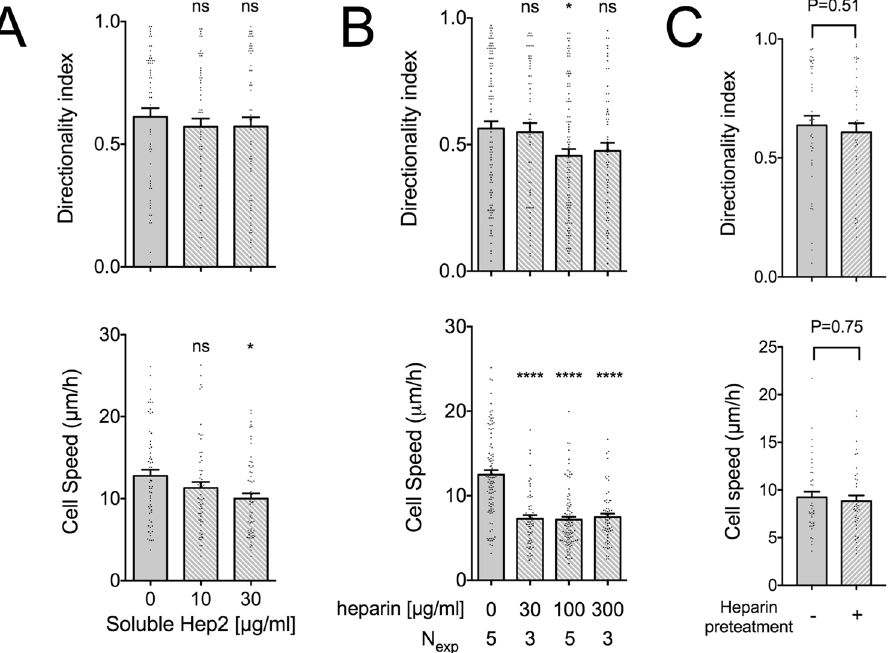
Figure 4. Soluble heparin reduces fibroblast speed on FN but has only a mild effect on directional persistence. ( A ) REF speed on FN-coated substrates (10 μ g/ml) slightly decreased with increasing concentrations of soluble Hep2 domain. Directional persistence on the other hand did not change. Values in presence of Hep2 were compared to the control condition using one-way ANOVA analysis (N exp = 3; n = 60). ( B ) REF speed markedly decreased in presence of soluble heparin on FN-coated substrates (10 μ g/ml), whereas directionality index showed a significant decrease at a heparin concentration of 100 μ g/ml, but not at 300 μ g/ml. Values in presence of heparin were compared to the control condition using one-way ANOVA analysis. N exp : number of independent experiments. Mean ± s.e.m. are presented. ns: not significant, * P < 0.05, **** P < 0.0001. ( C ) FN- coated TCPS substrates (10 μ g/ml) were pre-incubated with 100 μ g/ml heparin for 15 minutes at 37 °C, washed 3 times with PBS and seeded with REF. Cell speed and directionality index did not show significant differences compared to untreated FN-coated substrates. Mean ± s.e.m. are presented (n = 40 cells; N exp = 2). Values were compared using Mann-Whitney